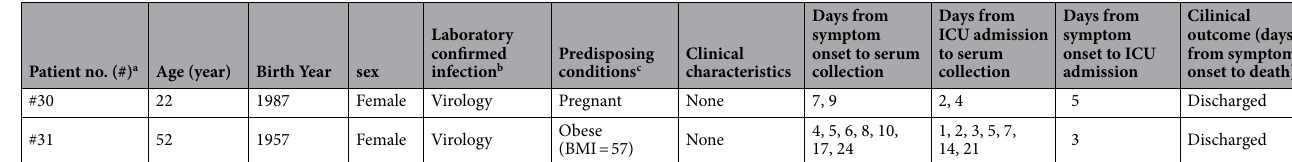
Table 1. A(H1N1)pdm09 virus-infected critically ill patient characteristics. ¥ Others: patient #1 (chronic lung/ renal/cardiovascular condition, diabetes mellitus, hematologic malignancy). *Fatal cases in bold. † Bacterial pneumonia (b. pneumonia) was detected 1–45 days post ICU admission (dpicu). a Patients were admitted to ICU between 2009 (n = 29) and 2011 (n = 2, #21 and #26). All patients, except #20, received invasive mechanical ventilation use. The patients did not receive influenza vaccine. b Infection with wt-CA/09-like viruses were confirmed by virology (n = 27, RT-PCR and/or virus isolation) or serology (n = 4, ≥ fourfold rise in HAI titers to wt-CA/09). c Obese, Body mass index (BMI) ≥ 30; COPD, chronic obstructive pulmonary disease; ECMO, extra-corporal membrane oxygenation.